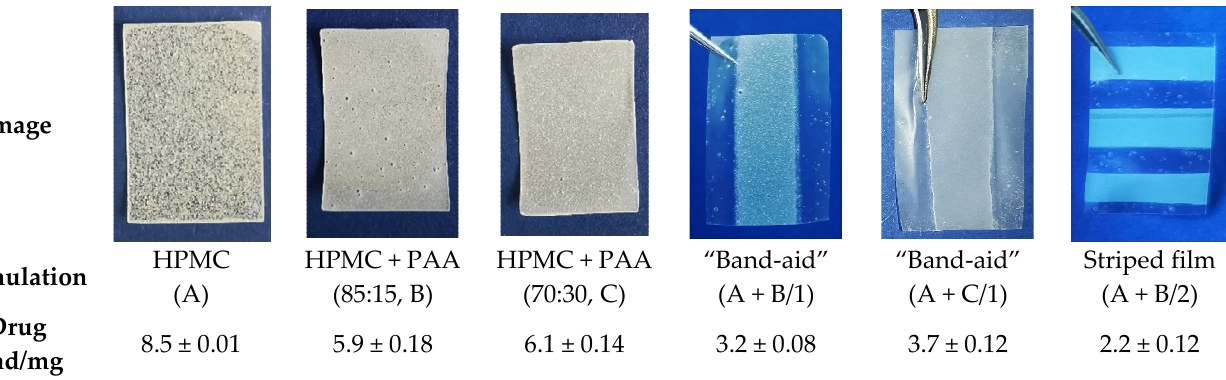
Figure 10. Drug load per film (A: HPMC, B: HPMC + PAA 85:15, C: HPMC + PAA 70:30, n = 3–5, mean ± sd). The pictures were taken in front of blue background.